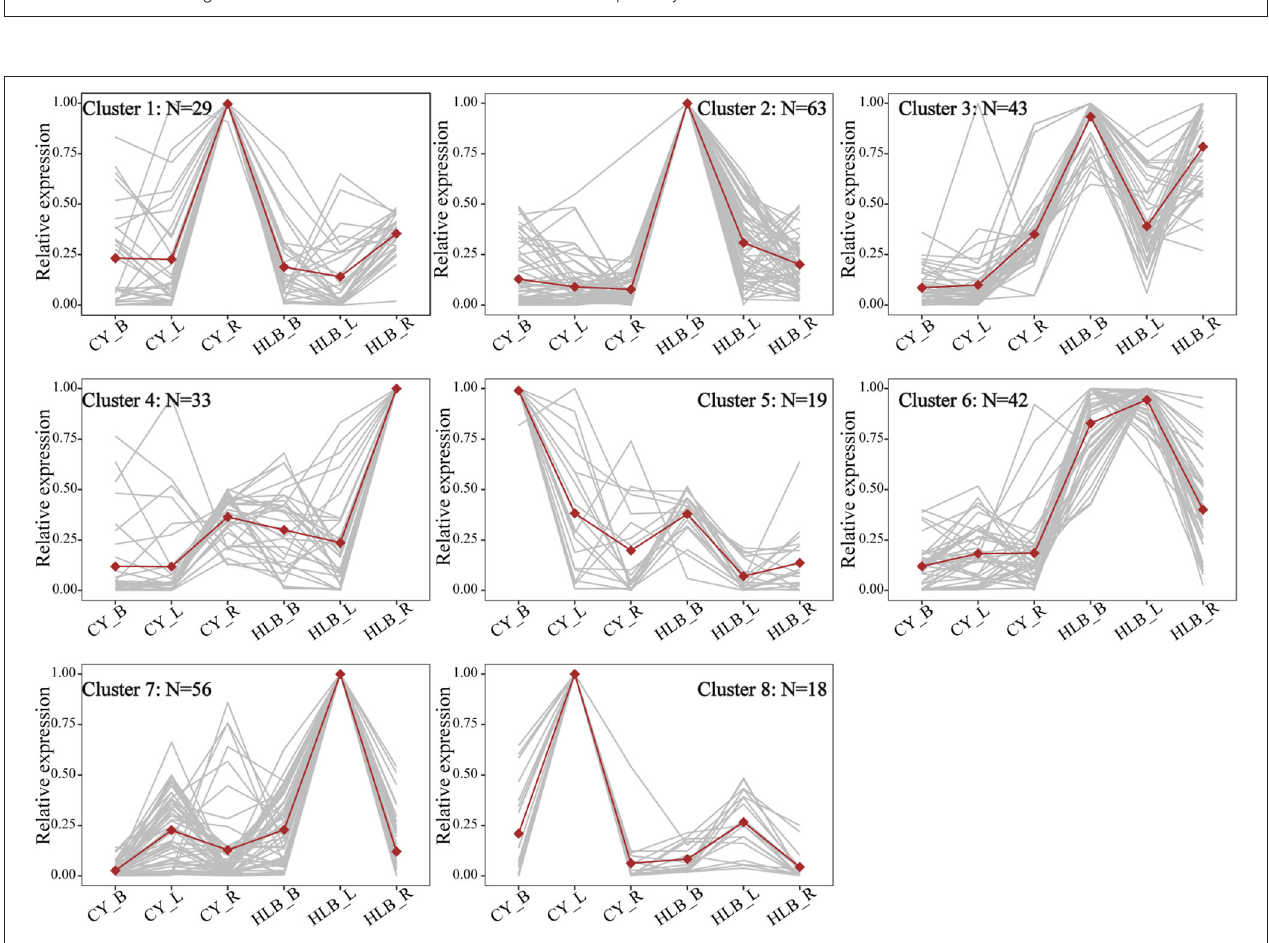
FIGURE 4 | Expression patterns of common DEGs among all tissues. CY_B, CY_L, and CY_R represent healthy barks, leaves, and roots, respectively. HLB_B, HLB_Y, and HLB_R represent C Las-infected barks, leaves, and roots, respectively. Normalized TPM values were averaged across replicates for each tissue. Dots represent the average profiles of genes belonging to each cluster. Gray lines represent the profiles of individual genes from a cluster.